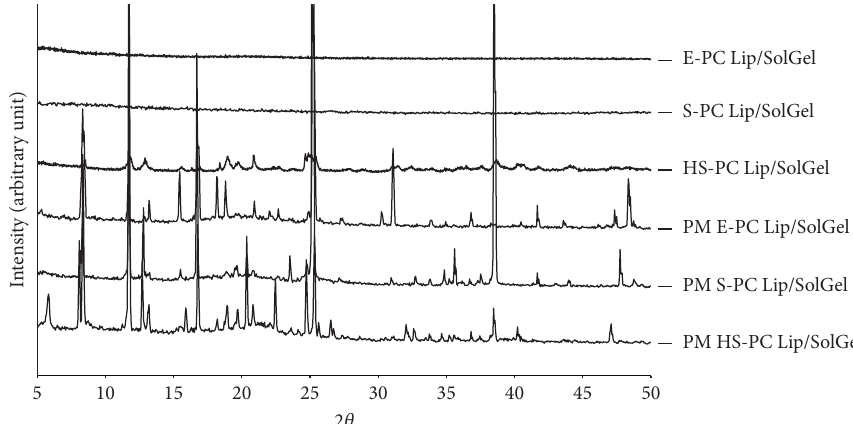
Figure 3: XRD diffractograms of CUR-loaded liposomal solid gel formulations. Samples were scanned within a range of reflecting angle 2 θ of 5 to 50 ° at room temperature. E-PC Lip/SolGel, egg-phosphatidylcholine liposomal solid gel; S-PC Lip/SolGel, soy-phosphatidylcholine liposomal solid gel; HS-PC Lip/SolGel, hydrogenated-soy-phosphatidylcholine liposomal solid gel; PM, the physical mixture of each formulation.